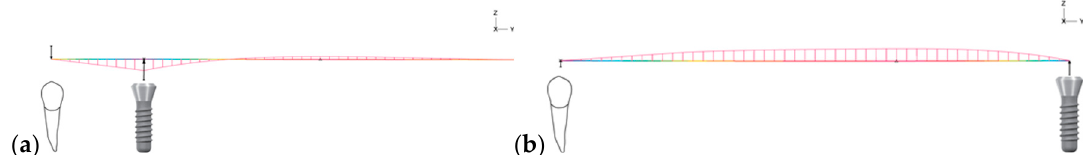
Figure 12. Bending moment diagram for the simplified IARPD models. ( a ) At the PM model the loading of the acrylic teeth promotes hogging of the structure in the most anterior portion, which is represented as negative bending moment. Maximum bending moment (absolute value) takes place at the rigid connection between the ball attachment and the matrix inserted in the prosthesis. The reaction of the oral mucosa to the load applied over the acrylic teeth promotes sagging of the most distal portion of the structure, which is represented as a positive bending moment in the diagram. The abutment tooth is subjected to tension and the implant to compression. ( b ) At the MO model the loading of the acrylic teeth promotes sagging of all non-supported, which is represented as positive bending moment. Maximum bending moment (absolute value) takes place approximately at the midpoint of the acrylic base. Both supports are subjected to compression forces.